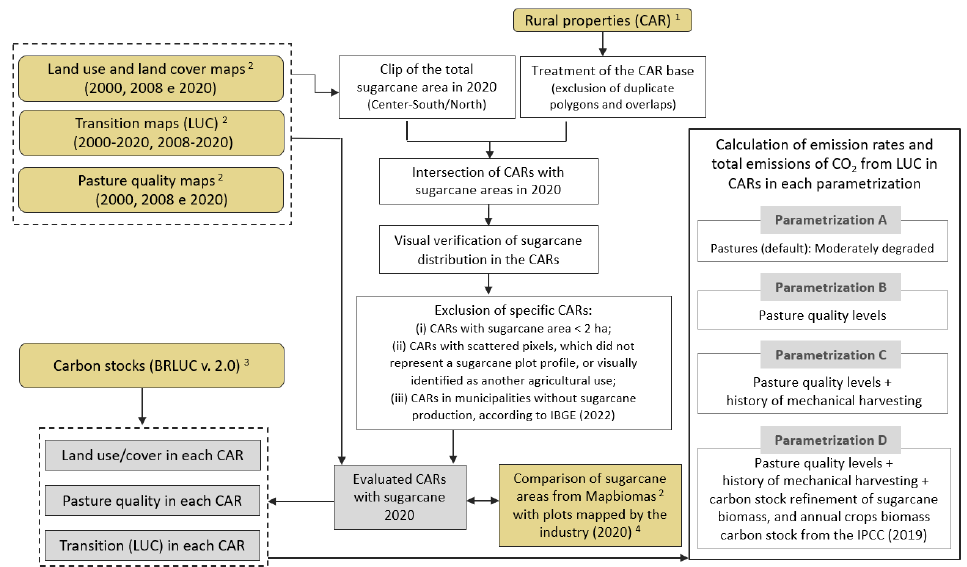
Figure 1. Flowchart for diagnosing land use and estimating CO 2 emissions due to LUC in CARs. Developed by the authors. Source: 1 Imaflora [42]; 2 MapBiomas—col. 6 [31]; 3 Garofalo et al. [10]; 4 Raizen